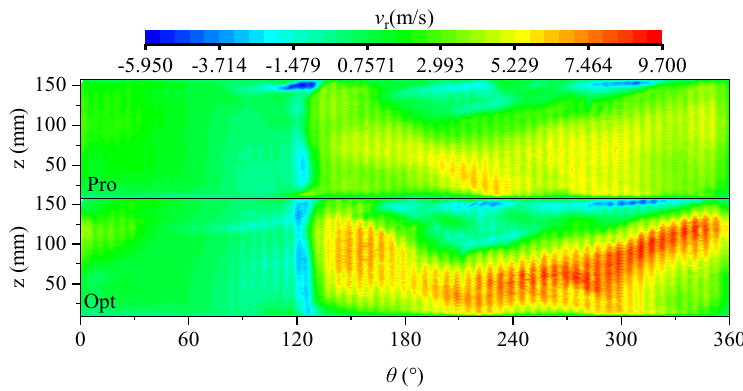
Figure 16. The contrast of radial velocity at the impeller outlet.